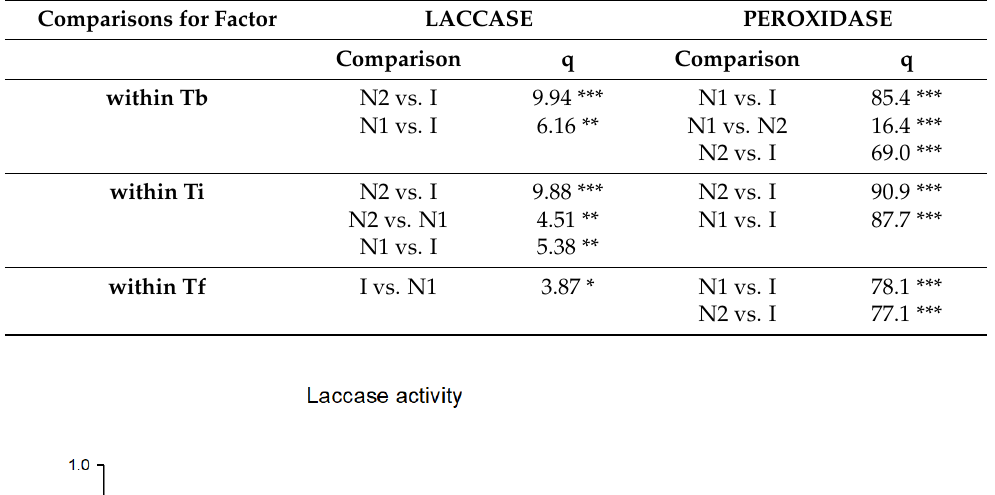
Table 1. q values of Tukey HSD tests for soil types x time interactions in pair comparisons according to laccase and peroxidase activities. Asterisks indicate significant differences among soil sampling